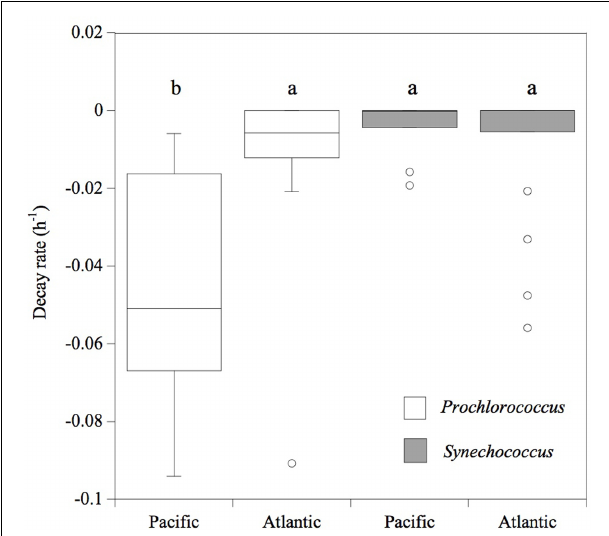
FIGURE 5 | Cell decay rates (h − 1 ) of Prochlorococcus (white box) and Synechococcus (gray box) cells. The boxes show the lower and upper quartiles. The line represents the median value for each ocean, the caps are the minimum and maximum values, and the dots are outlier values. The boxes connected with the same letter are not significantly different ( p > 0.05).